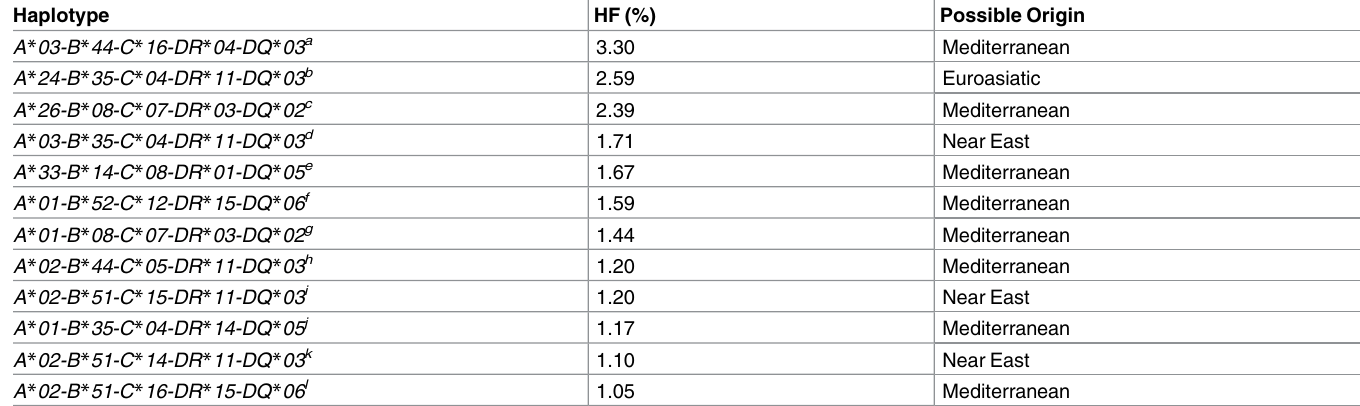
Table 4. The twelve most frequent HLA-A, -B, -C, -DRB1 and -DQB1 extended haplotypes in Kurds. Haplotype HF